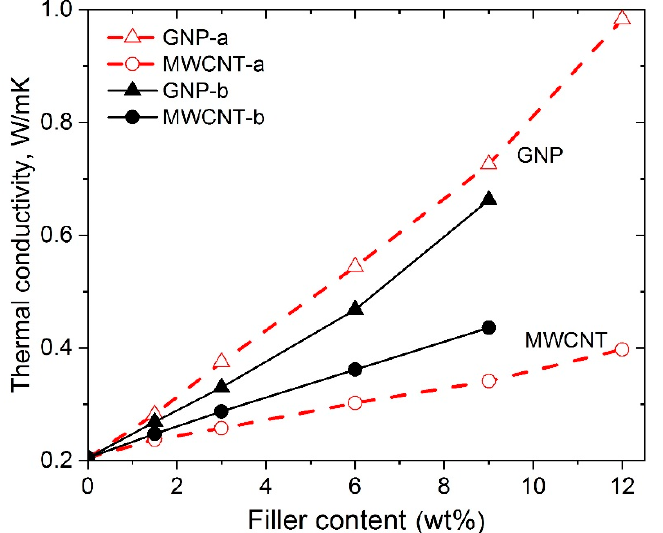
Figure 8. Thermal conductivity of nanocomposite series NC-a and NC-b, as varying the GNPs and MWCNTs contents.